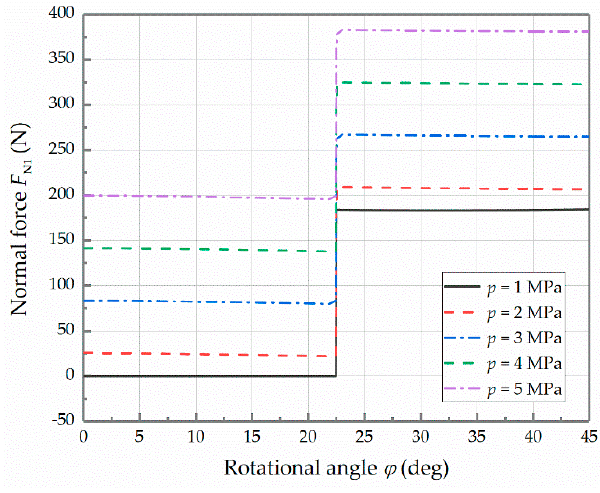
Figure 10. Curves of the normal force F N1 at different pressures.